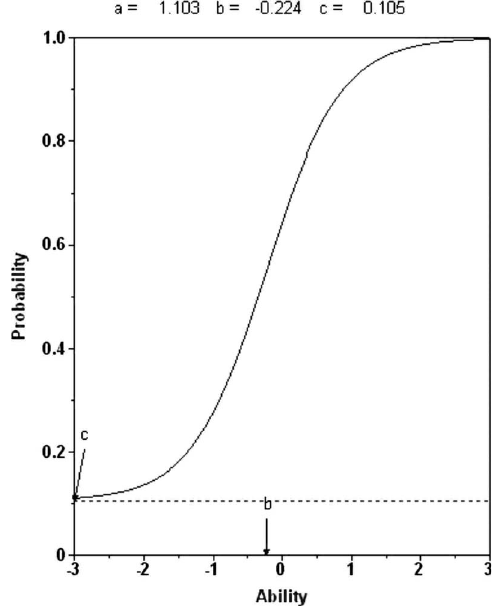
FIG. 1. Item response curve for item 45 of the 2004 11th grade